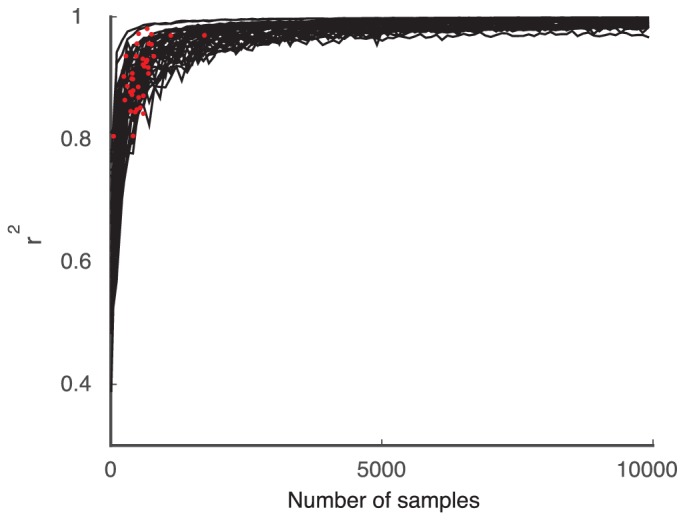
The performance of the model ρub (black curves) on synthetic data using increasing numbers of Poisson realizations approaches 1.The Poisson model computed with the same number of trials as the data is shown for comparison (red dots).